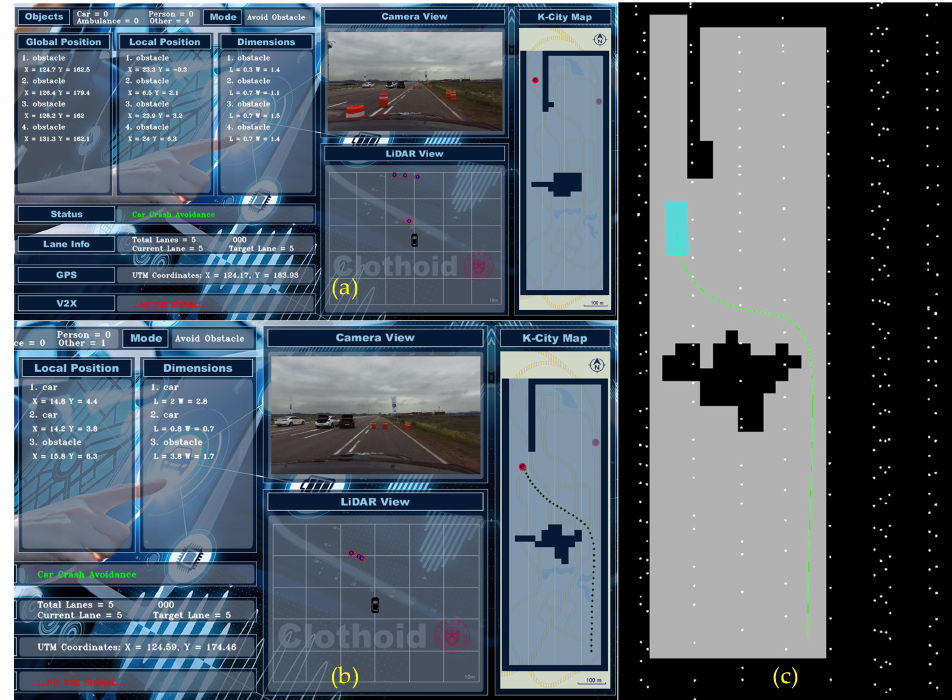
Figure 17. ( a , b ) Clothoid visualizer application; ( c ) occupancy grid map with path generation.